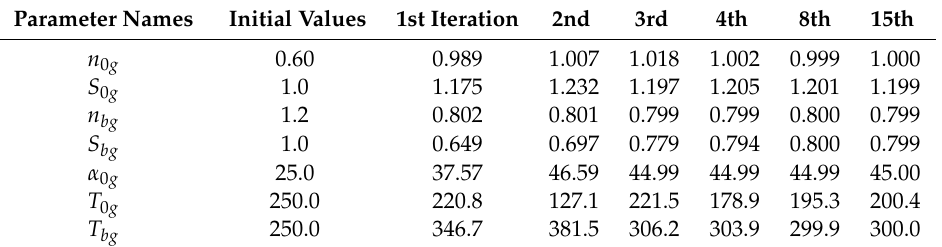
Table 2. Parameter convergence histories. True values: n 0 = 1.0 (non-dimensionalized), S 0 =